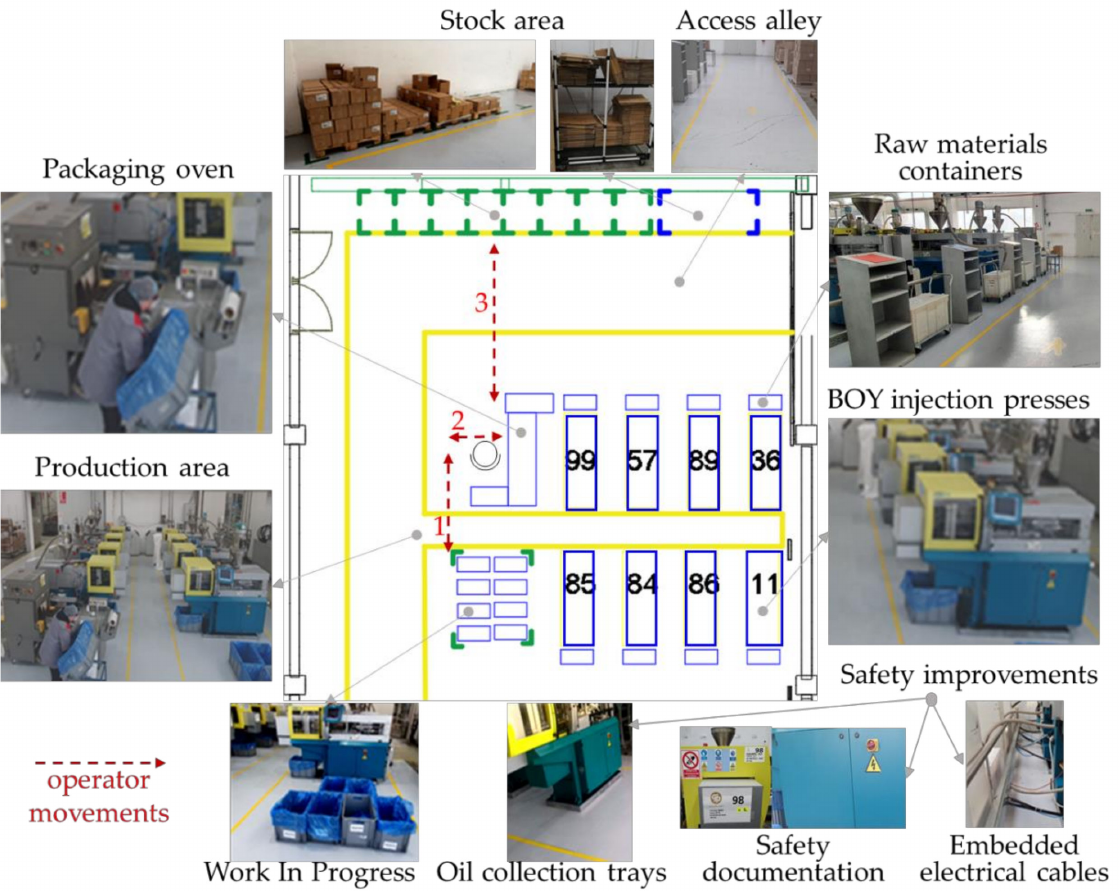
Figure 23. Final layout and resources of the production